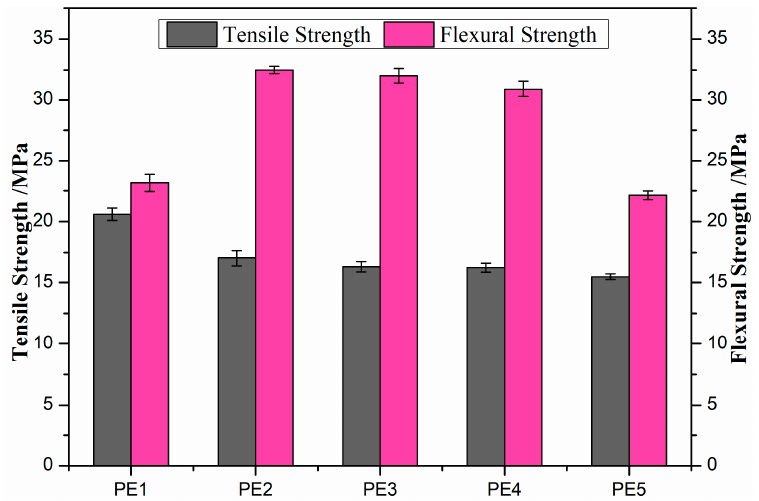
Figure 6. Tensile and flexural strength of HDPE and HDPE/IFR composites.